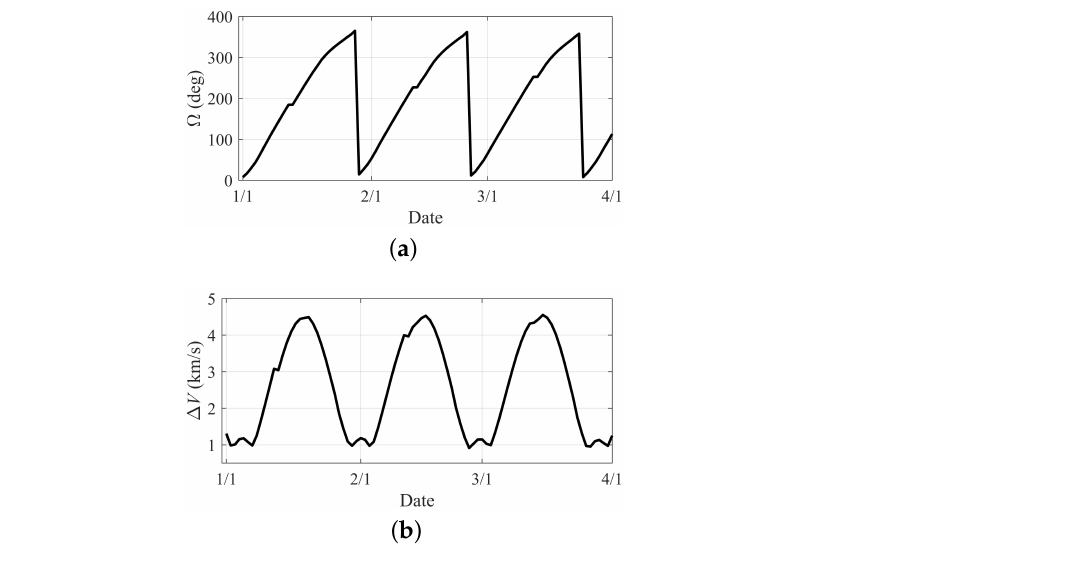
Figure 7. RAAN and ∆ V of the precise trajectories in the first three months of 2030. ( a ) The RAAN of the perilune in the first three months of 2030; ( b ) The ∆ V required at the perilune in the first three months of 2030. Table 2. Comparison of the obtained opportunity between this paper and the